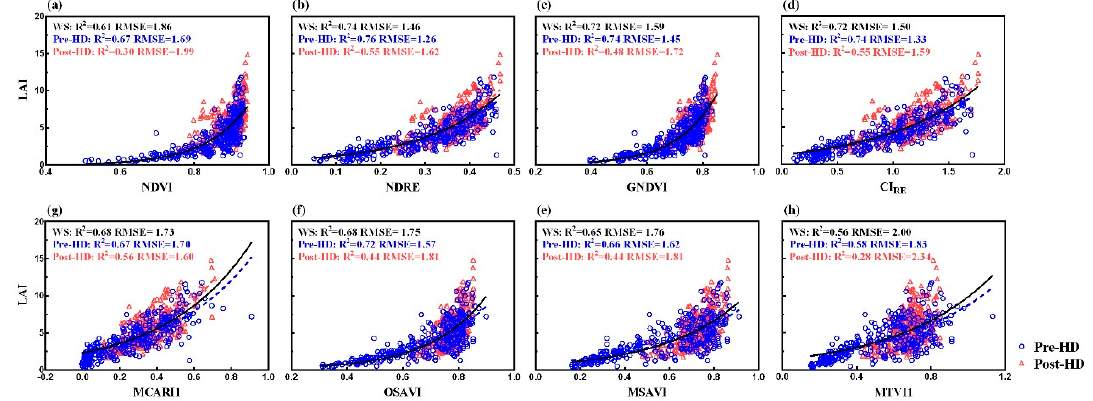
Figure 5. Leaf area index plotted against vegetation indices: ( a ) NDVI; ( b ) NDRE; ( c ) GNDVI; ( d ) CI RE ; ( e ) MCARI1; ( f ) OSAVI; ( g ) MSAVI; ( h ) MTVI1. WS represents the whole season, Pre-HD represents pre-heading stages and Post-HD represents post-heading stages.